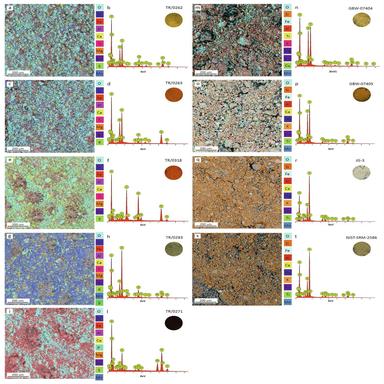
SEM-EDS combined map in false colors with relative elements compounds (left column) and spectra and surface sample on stub (right column) of soil pigments and CRMs. (a, b) Natural Sienna (TR/0262); (c, d) burnt Sienna (TR/0263); (e, f) red earth from Pozzuoli (TR/0318); (g, h) green earth (TR/0283); (i, l) burnt shadow earth from Cyprus (TR/0271); (m, n) GBW-07404; (o, p) GBW-07405; (q, r) JG-3; (s, t) NIST-SRM-2586. (For interpretation of the references to colour in this figure legend, the reader is referr